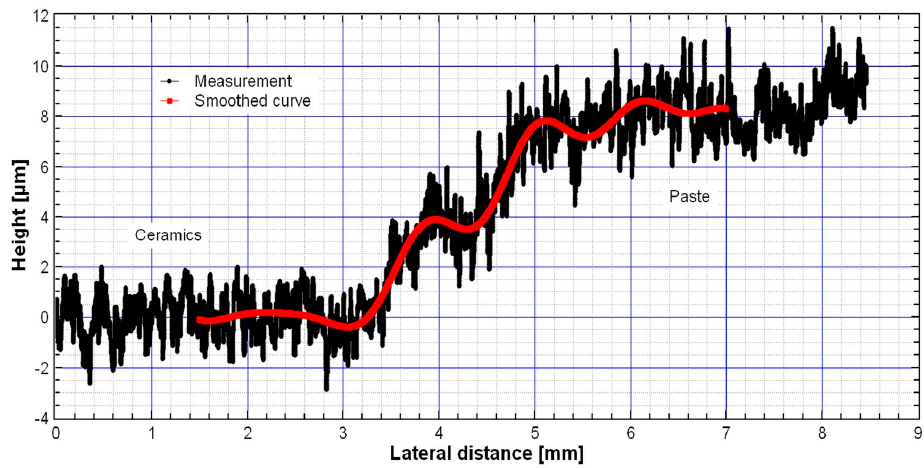
Figure 10. Thickness measurement of the TiCe-0.5:0.5-40 film on the substrate.